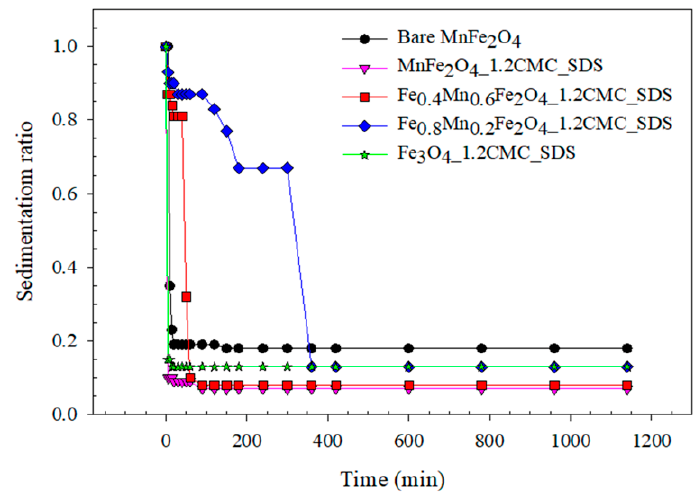
Figure 9. Sedimentation ratio as a function of time of the synthesized bare MnFe 2 O 4 and